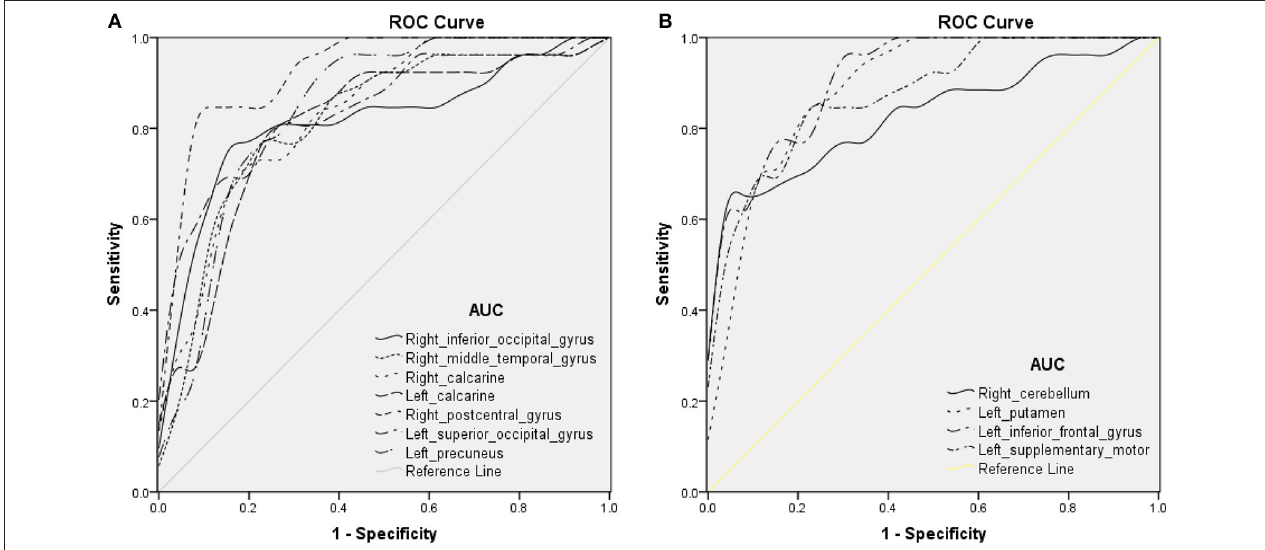
FIGURE 5 | ROC curve analysis of the average ReHo of altered brain areas. ROC curve in ReHo values: (A) iridocyclitis < healthy volunteers: right inferior occipital gyrus [0.815; P < 0.001; 95% confidence interval (CI), 0.693–0.937], right middle temporal gyrus (0.815; P < 0.001; 95% CI, 0.695–0.936), right calcarine (0.834; P < 0.001; 95% CI, 0.726–0.942), left calcarine (0.806; P < 0.001; 95% CI, 0.683–0.930), right postcentral gyrus (0.926; P < 0.001; 95% CI, 0.854–0.998), left superior occipital gyrus (0.845; P < 0.001; 95% CI, 0.738–0.952), and left precuneus (0.843; P < 0.001; 95% CI, 0.733–0.954); (B) iridocyclitis > healthy volunteers: right cerebellum (0.833; P < 0.001; 95% CI, 0.719–0.947), left putamen (0.891; P < 0.001; 95% CI, 0.802–0.979), left inferior frontal gyrus (0.916; P < 0.001; 95% CI, 0.844–0.987), and left supplementary motor area (0.879; P < 0.001; 95% CI, 0.788–0.969). Abbreviations: IC, iridocyclitis; AUC, area under the ROC curve.